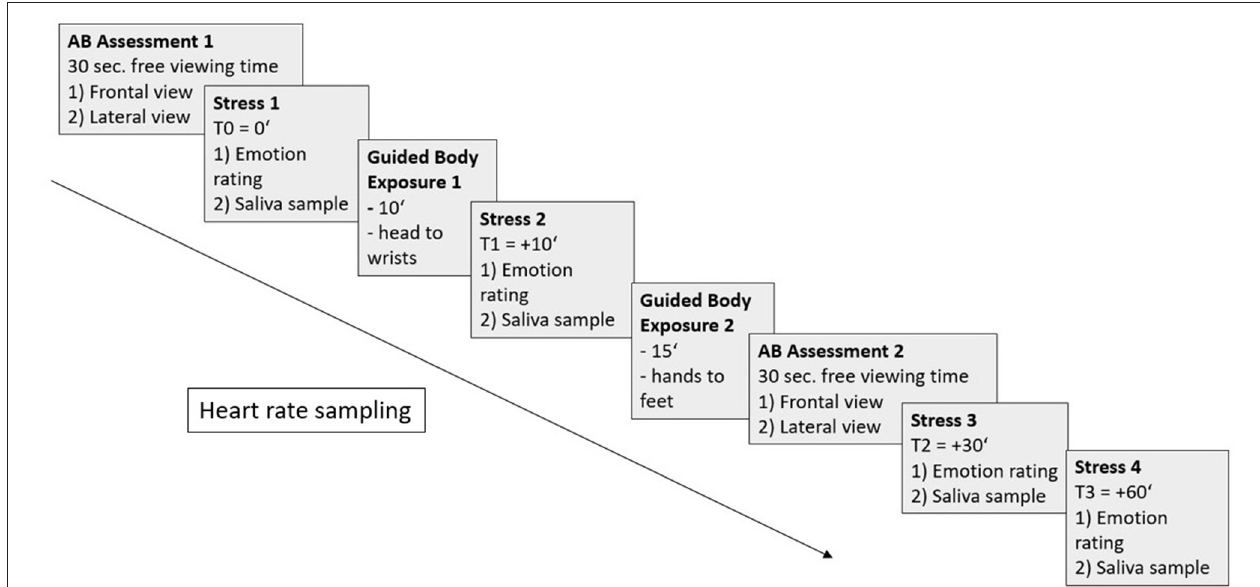
FIGURE 2 | Standardized procedure of an exposure session with attentional bias (AB) assessments (1,2) for each frontal and lateral view (30s each), stress measurements (1-4) via emotion ratings and saliva samples, guided body exposure times (1,2), and heart rate sampling (from AB Assessment 1 to Stress